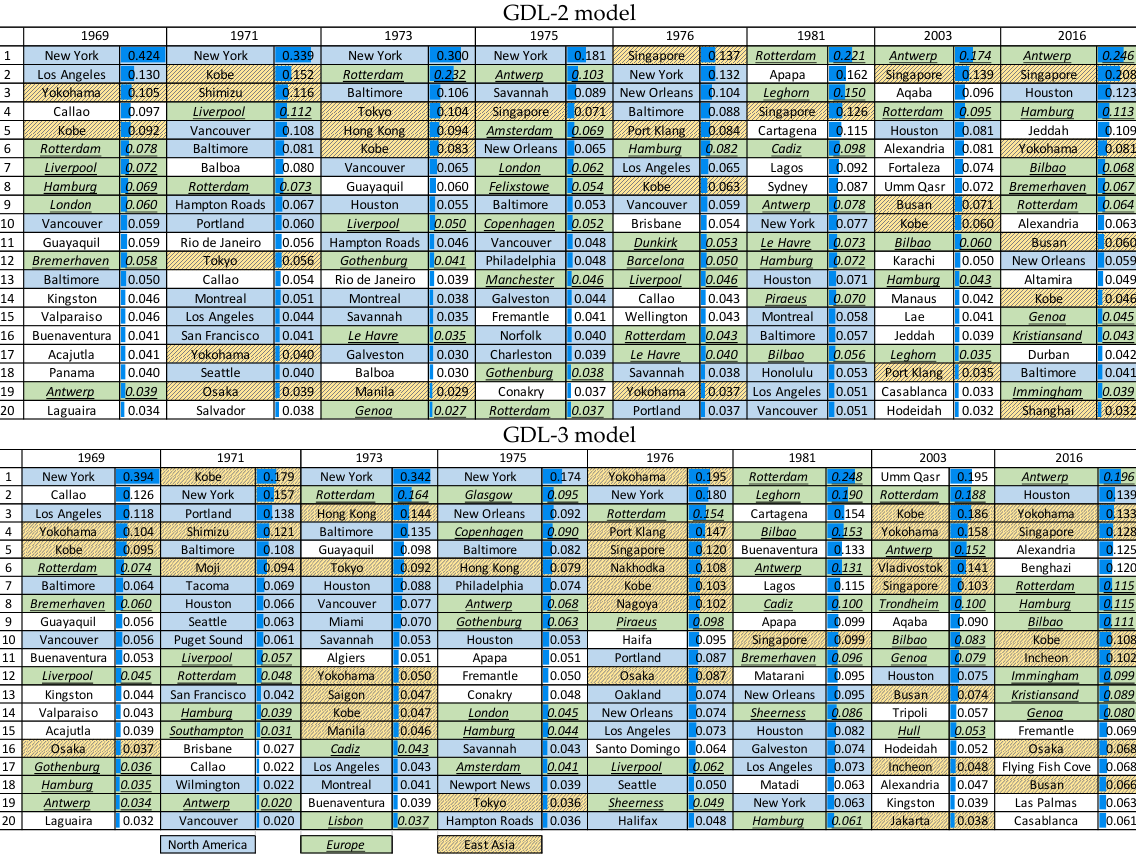
Table 2. Number of major communities in the GDL-1, 2, and 3 model networks.